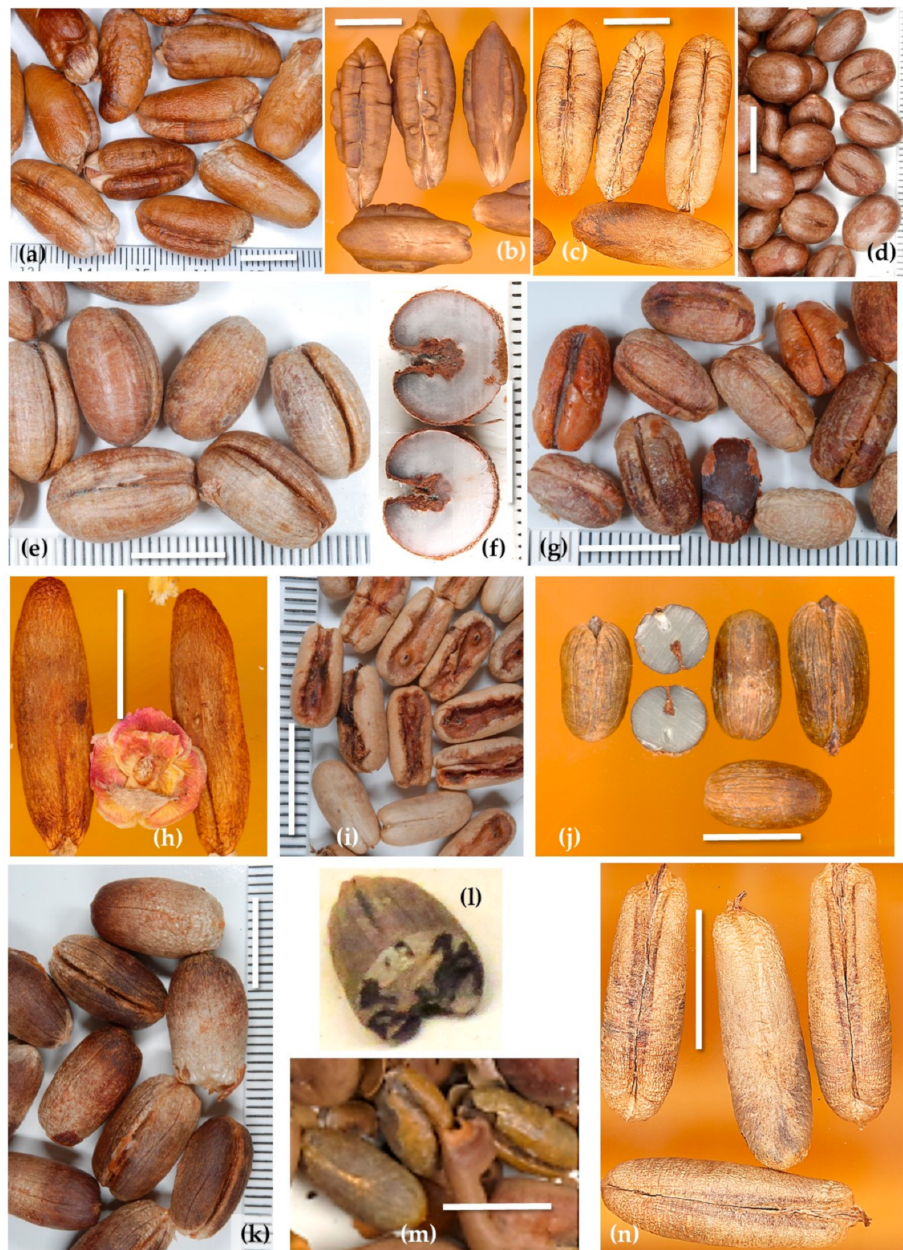
Figure 5. Diversity of Phoenix: seeds. ( a ), P. atlantica (Ilha Sao Tiago, Cabo Verde); ( b ), P. dactylifera “Medjool” Western Group (W_DAC) (Morocco); ( c ), P. dactylifera “Haziz” Western Group (W_DAC) (US); ( d ), P. paludosa (near Bangkok, Thailand); ( e , f ), P. sylvestris (India); ( g ), P. loureiroi (Manipur, India); ( h ), P. dactylifera Eastern Group (E_DAC) (Socotra, Yemen); ( i ), P. roebelenii (Orihuela, Spain); ( j ), P. theophrasti (Crete, Greece); ( k ), P. reclinata var. reclinata (Rwanda); ( l , m ), P. andamanensis (North Andaman, India); ( n ), P. dactylifera “Dairy” Eastern Group (E_DAC) (UAE). Abbreviations for the major P. dactylifera geographical groups: E_DAC: North Africa and West Asia P. dactylifera. W_DAC: North Africa and Mediterranean P. dactylifera. Scale bar: 1 cm. Images: ( a – k , n ). Diego Rivera and Concepci ó n Ob ó n; l. Teresa Egea Molines in the herbarium FI; m. Royal Botanic Gardens Kew, http://apps.kew.org/herbcat/getImage.do?imageBarcode=K000736131, (accessed on 16 March